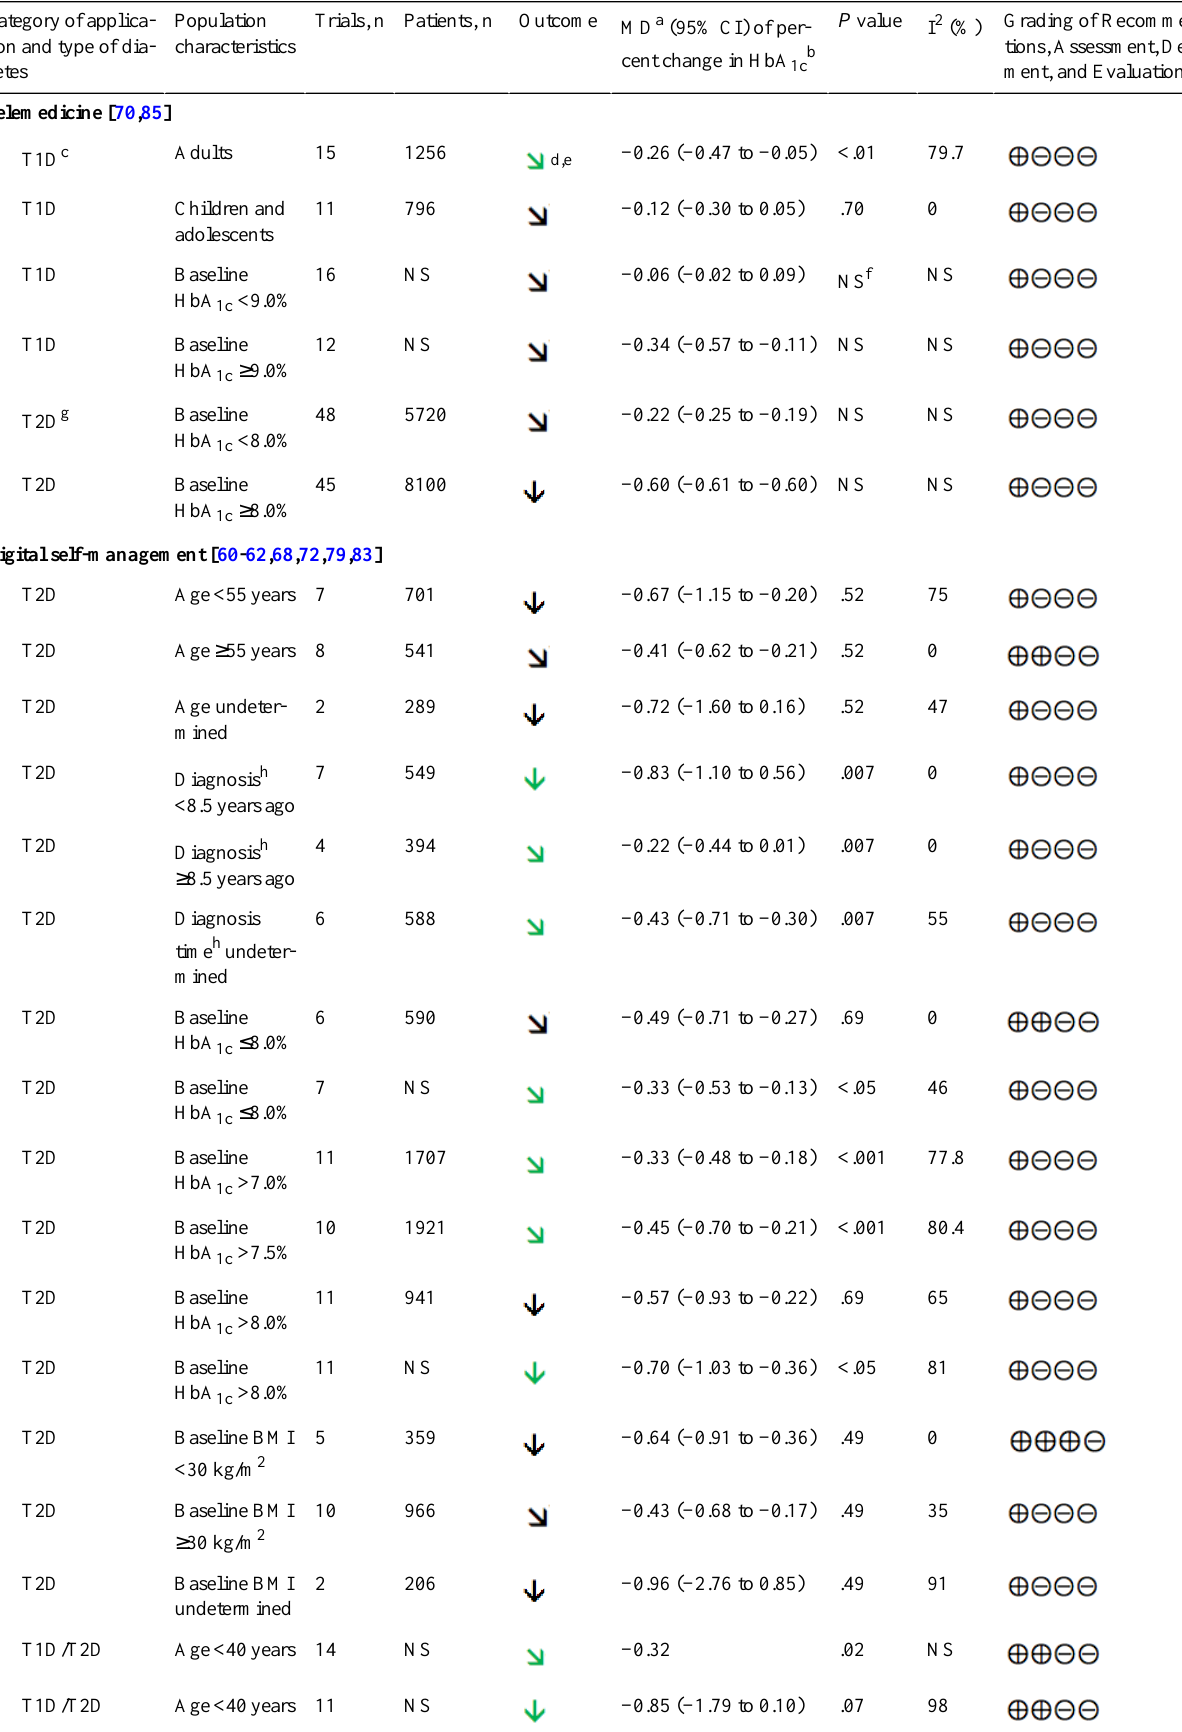
Table 5. Effectiveness of telemedicine on glycated hemoglobin in patients with diabetes, according to population characteristics.